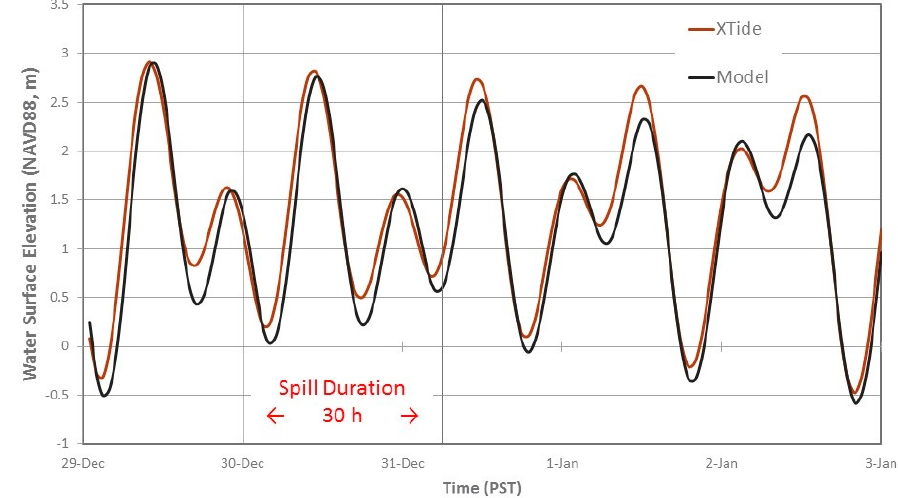
Figure 5. Extent of coverage for the Salish Sea Model.